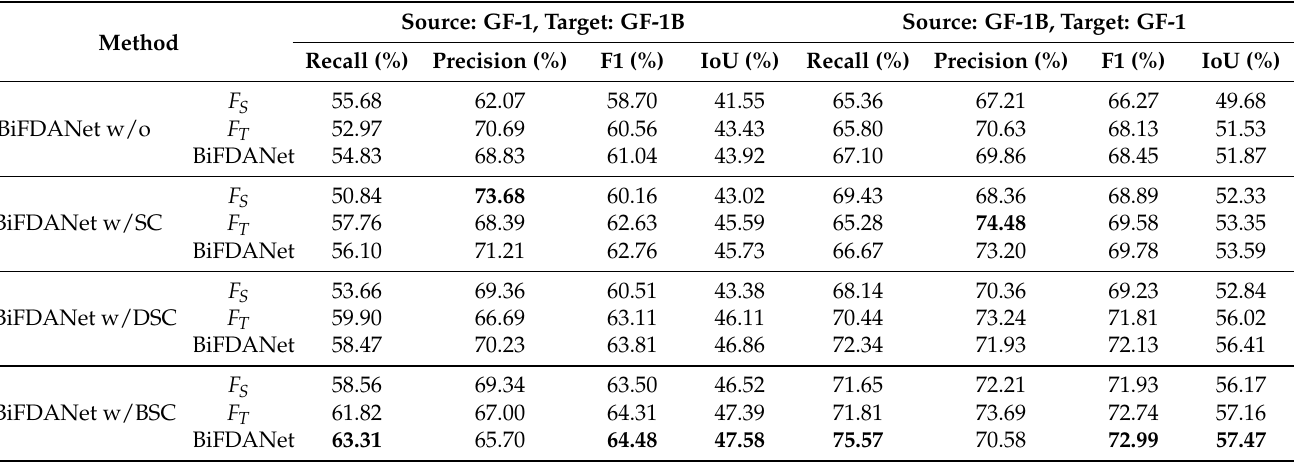
Table 4. Evaluation results of different semantic consistency loss on Gaofen dataset. The best values are in bold.